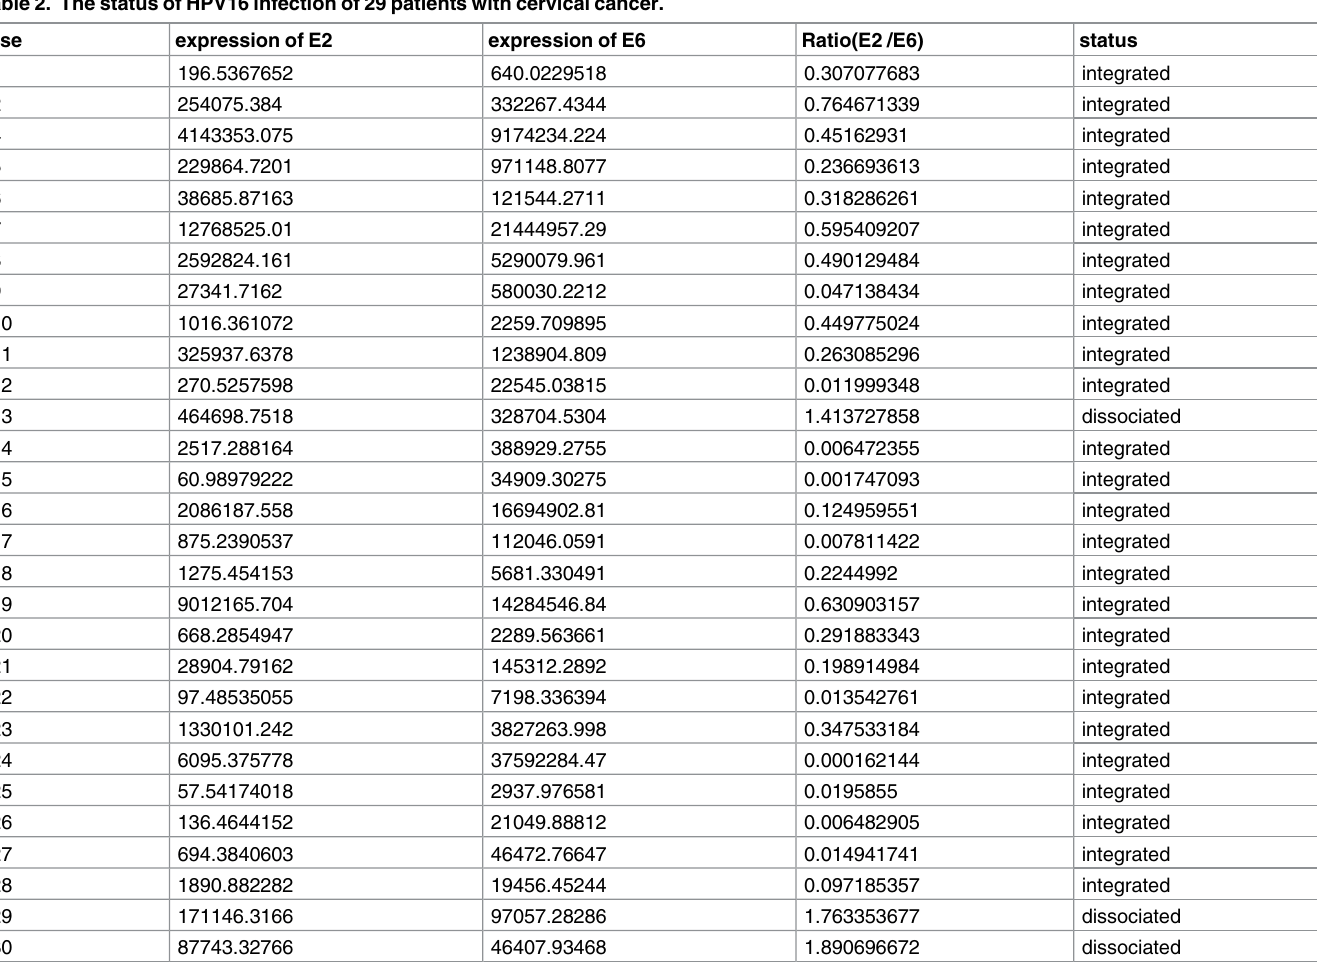
Table 2. The status of HPV16 infection of 29 patients with